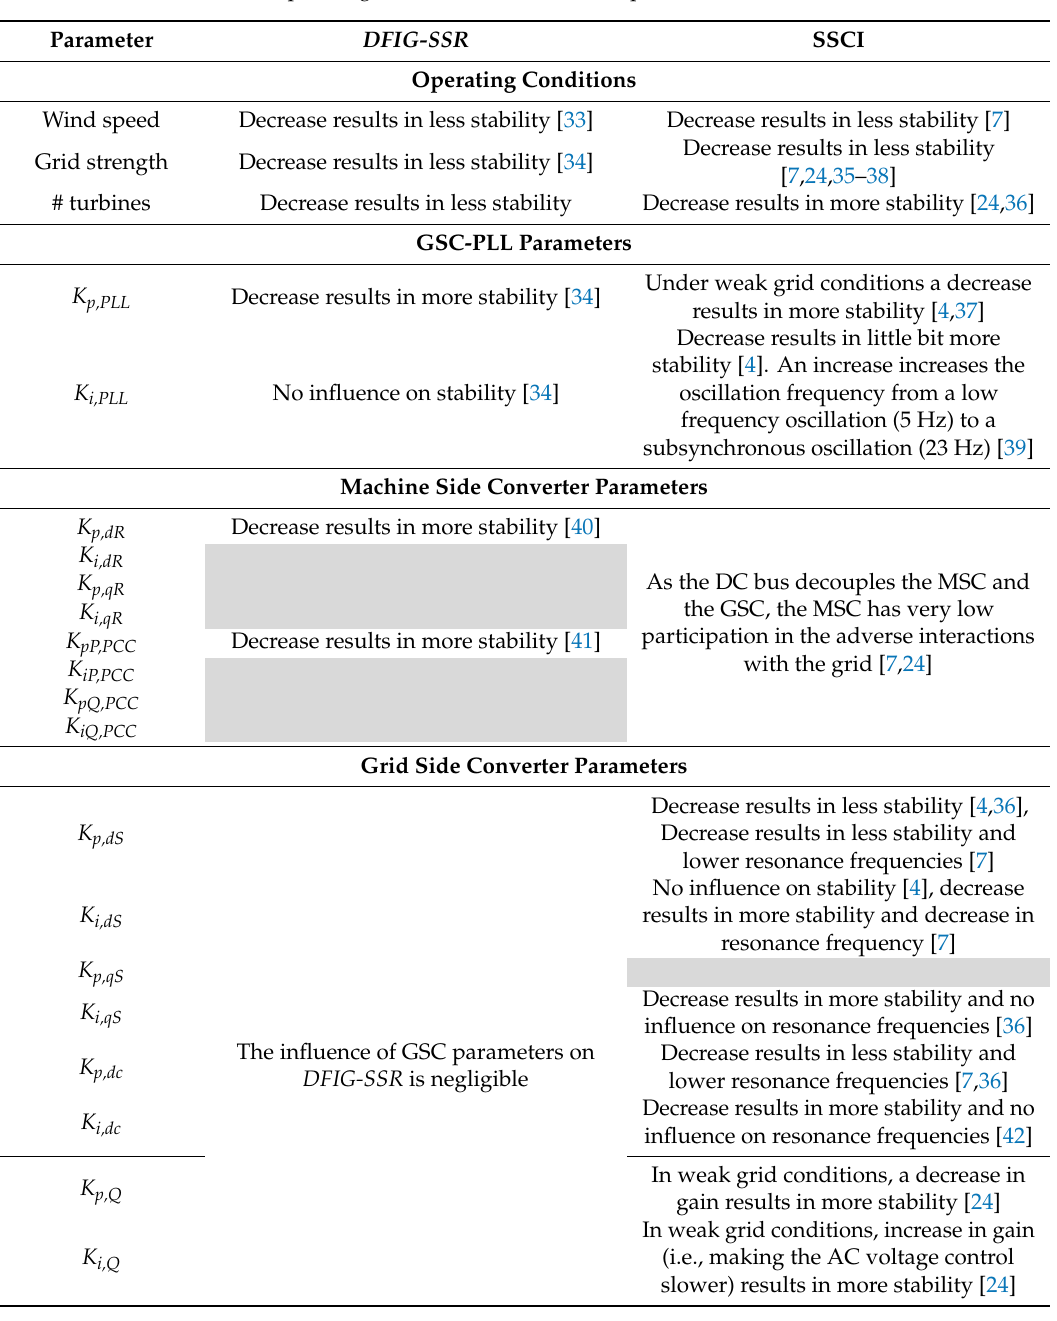
Table 1. Influence of operating conditions and converter parameters on DFIG-SSR and